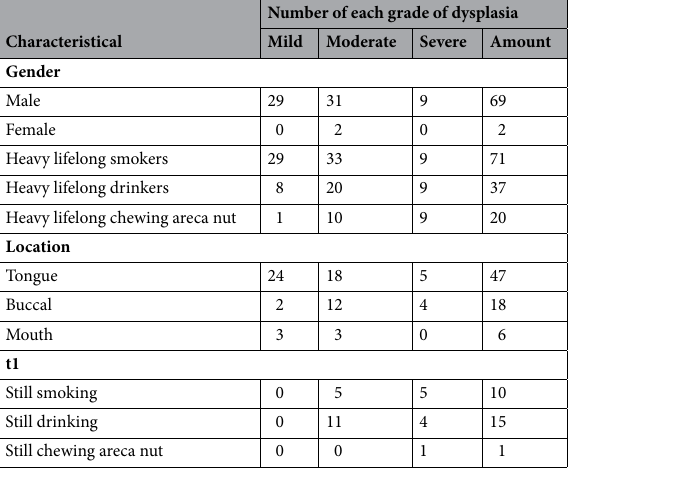
Table 1. Patients’ clinical